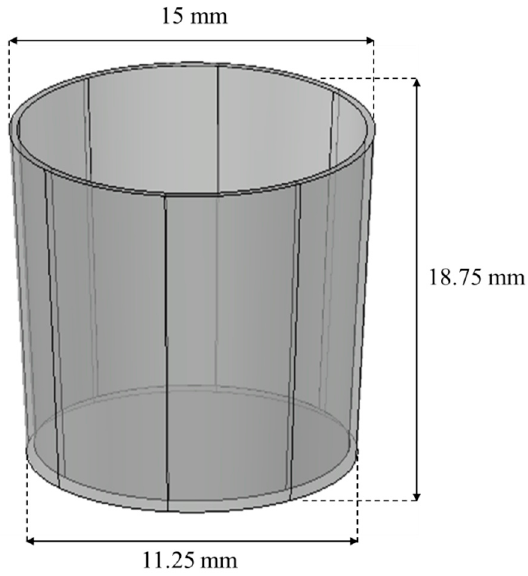
Figure 3. The dimension of chamber geometry.